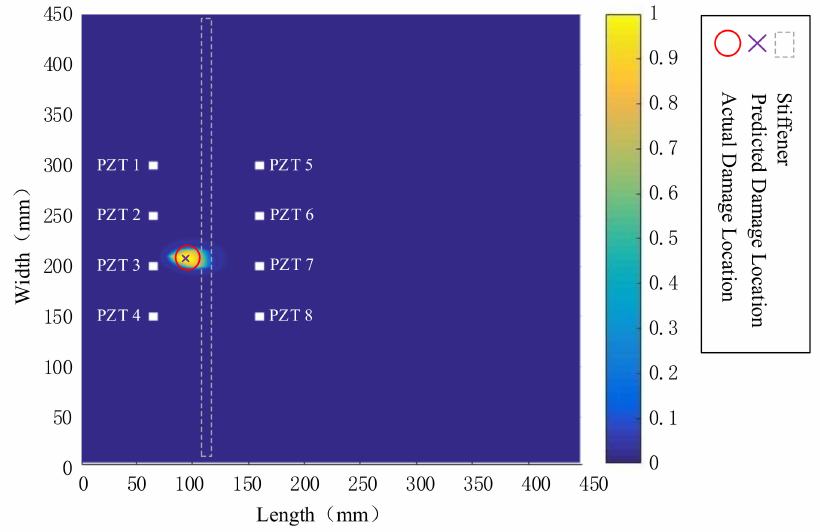
Figure 16. Damage location